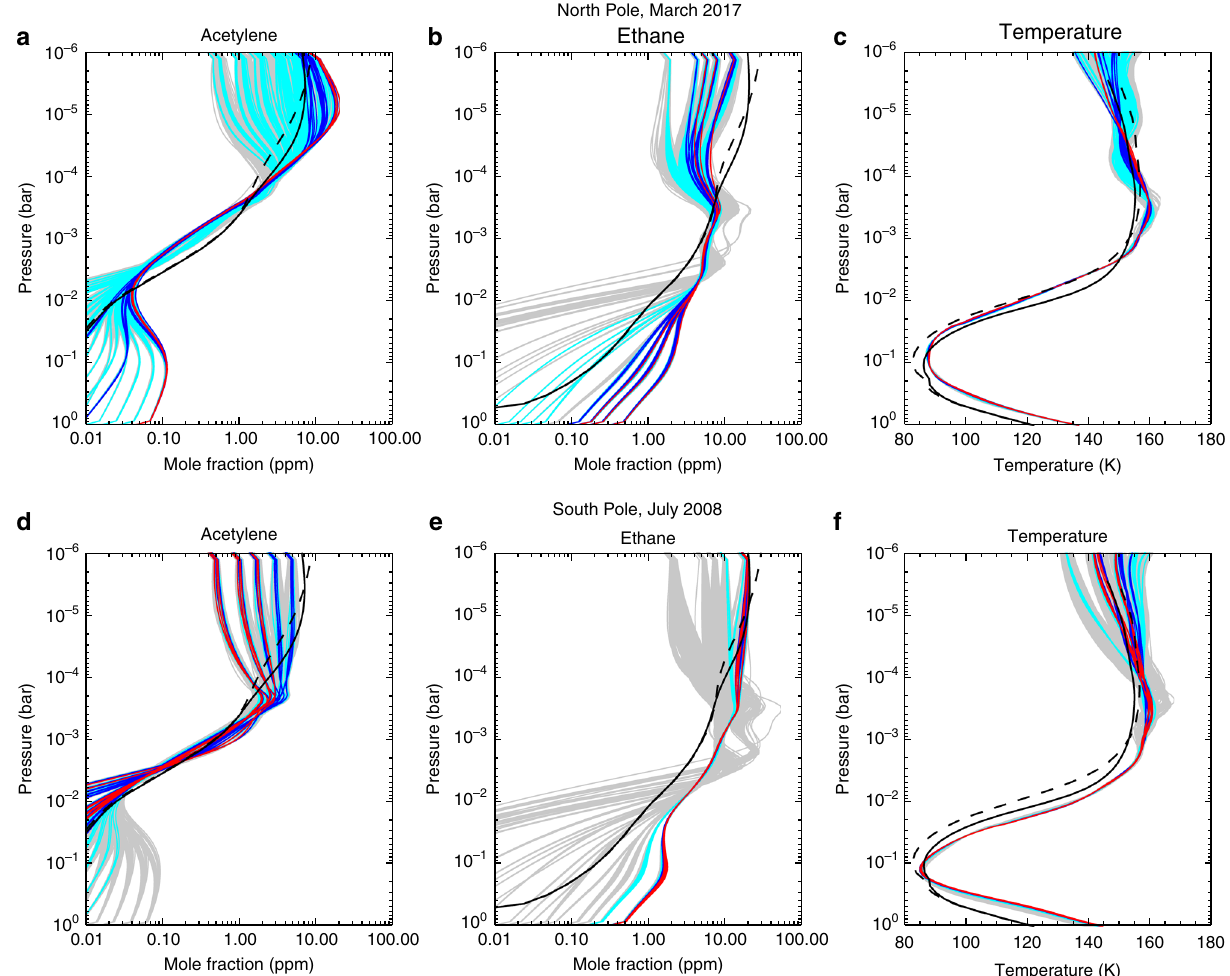
Fig. 6 Vertical distributions of temperature, acetylene and ethane derived from 0.5-cm − 1 spectral resolution data of both poles. The panels show COMPSITs targeting the north pole in March 2017 ( a – c , 84 – 87°N) and the south pole in July 2008 ( d – f , 83 – 88°S). A grid of 2000 a priori atmospheres (varying the temperature and hydrocarbon distributions) was employed as starting point. Red lines indicate pro fi les fi tting the spectrum within 1 σ of the best fi t, blue lines are for 2 σ , turquoise lines are for 3 σ and grey lines are for optimal estimates that do not fi t within the 3 σ envelope. We have con fi dence in retrieved pro fi les in altitude ranges where the pro fi les converge, irrespective of the a priori starting points. The hydrocarbon pro fi les are compared to the output of a diffusive photochemistry model 19 at ± 72° latitude for L s = 88° (dashed black line) and L s = 346° (solid black line). The temperature pro fi les are compared to the predictions or a radiative climate model 13 in the absence of stratospheric aerosols for ± 85° latitude and for L s = 88° (dashed black line) and L s = 346° (solid black